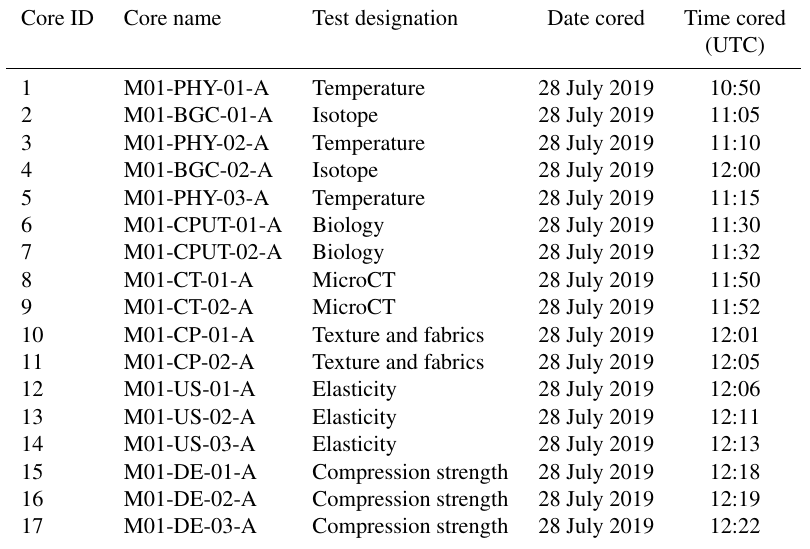
Table A2. Overview of core IDs of Pancake A, corresponding core names, testing designation, and date and time when